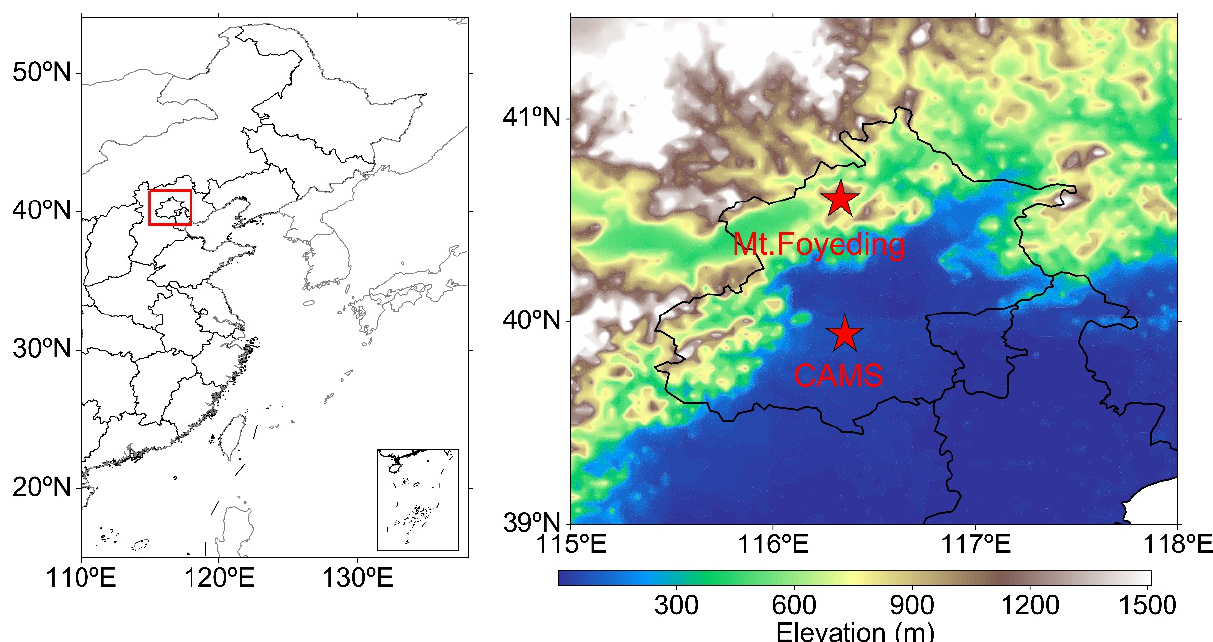
Figure 1. Geographical information for the two sites used in this observational campaign.